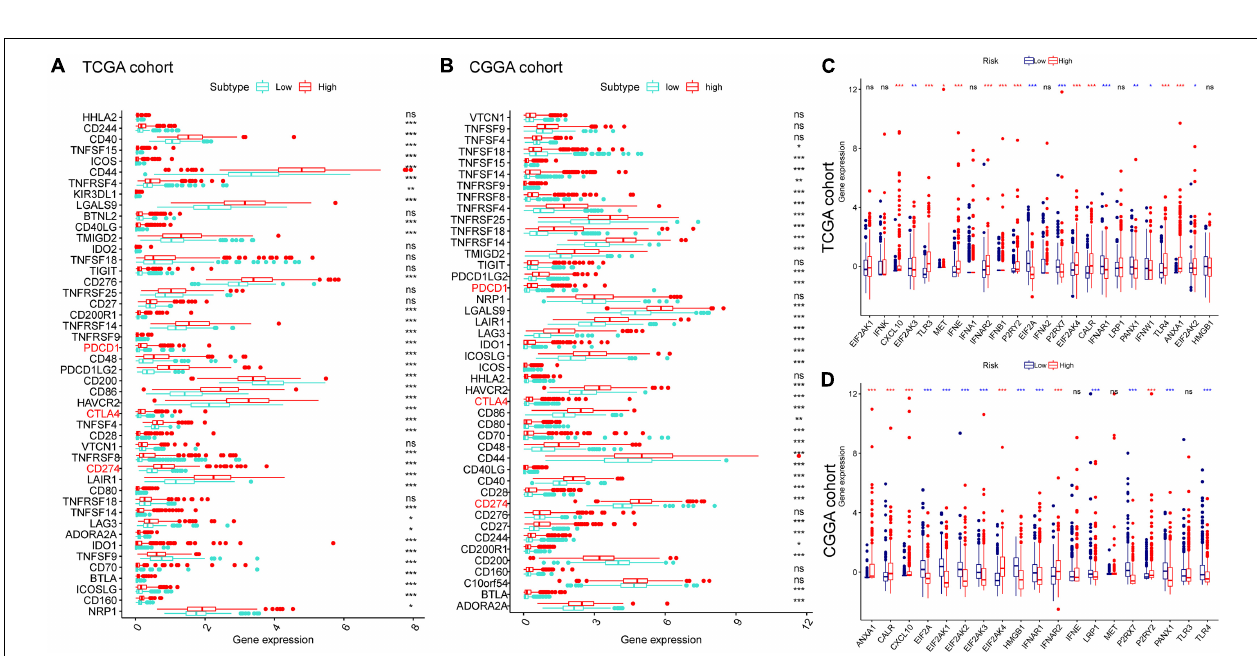
FIGURE 6 | Single sample gene sets enrichment analysis (ssGSEA) of immune hallmarks. Heatmap of ssGSEA scores among low- and high-risk groups in training (A) and validation (B) sets (red = positive, blue = negative). Boxplot of ssGSEA scores, stromal score, immune score, and tumor purity among low- and high-risk groups in TCGA (C) and CGGA (D) cohorts. *** p < 0.001, ** p < 0.01, * p < 0.05.